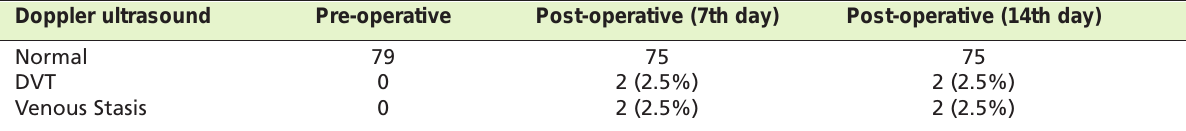
Distribution of patients according to Doppler ultrasound results Table II: